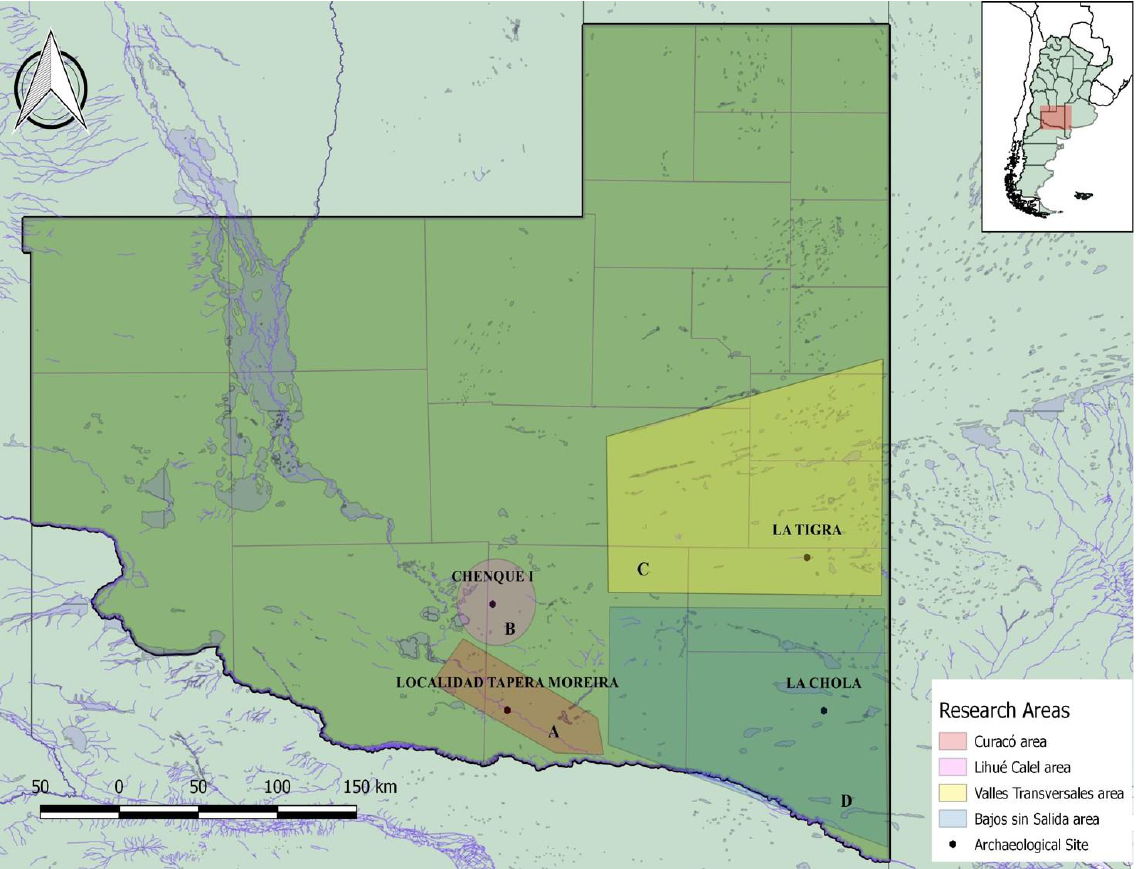
Figure 1. La Pampa province. Research areas and Archaeological sites. A- Curacó area; B- Lihué Calel area; C- Valles Transversales area; D- Bajos sin Salida area. QGIS